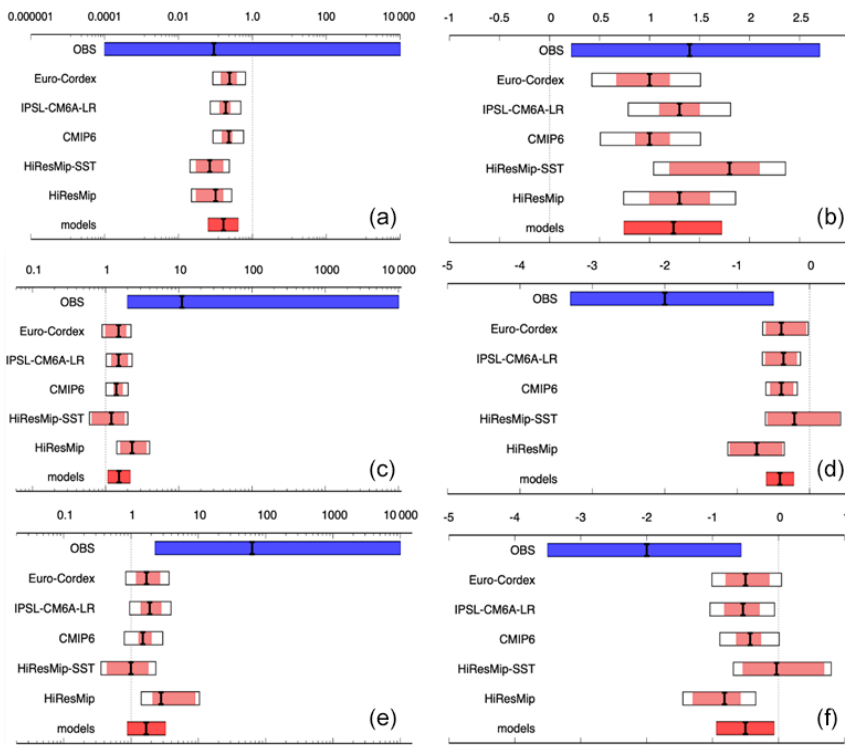
Figure 8. Changes between the past and present: summary of observational (blue) and model (red) results for probability ratio ( a, c, e , giving the change in the probabilities between the climate with a 1.2 ◦ C cooler global temperature and the current climate, as well as change in intensity [ ◦ C] (b, d, f) in the three indices, TNnApr–Jul (a, b) , TNnGDD250 (c, d) and TNnGDD250-350 (e, f) , as averaged over the study area (see rectangle in Fig. 2b). Extent of the bars gives the two-sided 95% confidence intervals accounting for internal variability (pink) of each ensemble and model spread added (white), calculated as explained in Philip et al. (2020), with the black marker indicating the best estimate. A weighted average of model results is shown in bright red (label “models”). Note that, for the index TNnApr–Jul, only EURO- CORDEX and HighResMIP-SST passed the validation step, but other models are included in the weighted average for reasons described in the